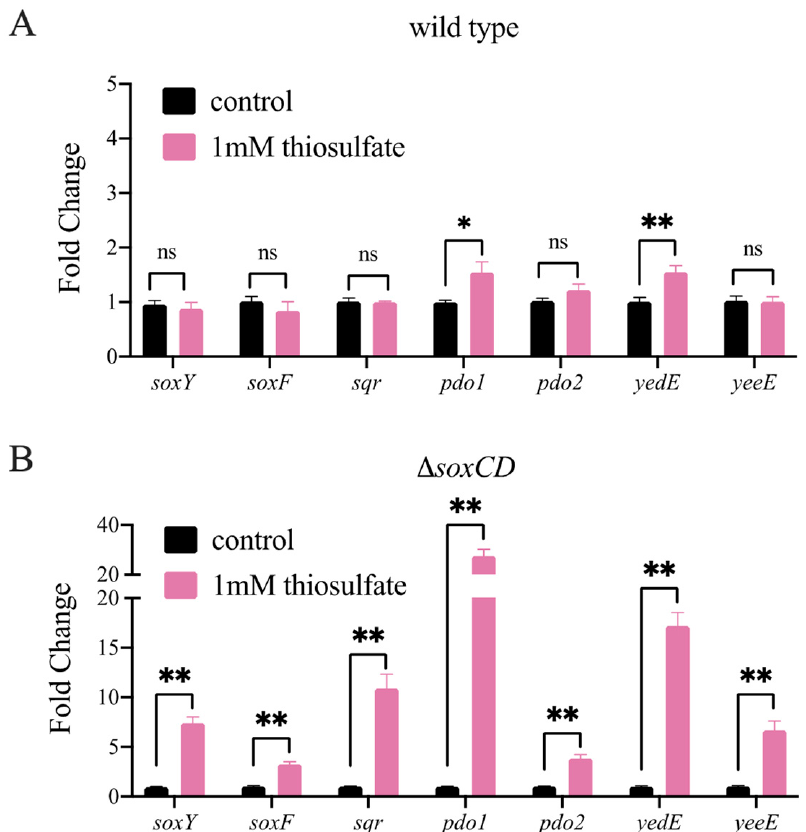
Figure 4. RT-qPCR analysis of sulfur-related gene transcripts in thiosulfate (1 mM)-treated and untreated strains. Strains were grown in mineral medium until the OD 600 reached 0.5. Then, 1 mM sodium thiosulfate was added to the medium. After 30 min of cultivation, RNA was extracted. A culture without the addition of sodium thiosulfate was used as the control. The relative expression levels of soxY , soxF , sqr , pdo1 , pdo2 , yedE , and yeeE in wild-type C. pinatubonensis JMP134 ( A ) and in